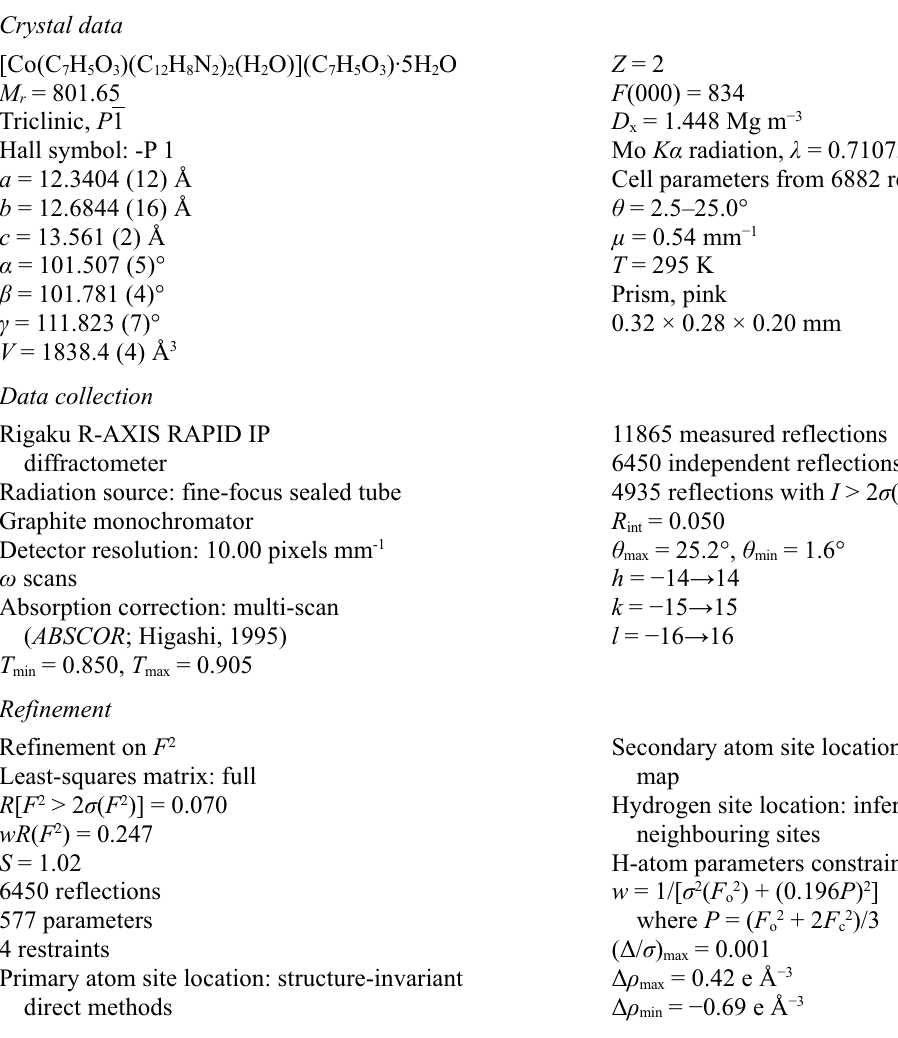
Figure 3 A diagram showing π - π stacking between N3-containing phen rings [symmetry code: (B) 2 - x ,1 - y ,1 - z ]. Aqua(3-hydroxybenzoato- κ O )bis(1,10-phenanthroline- κ 2 N , N ′ )cobalt(II) 3-hydroxybenzoate